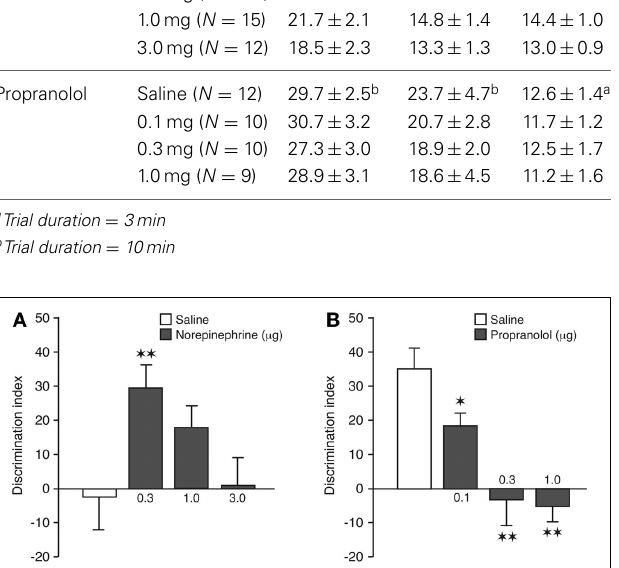
FIGURE 3 | Noradrenergic activation of the BLA modulates consolidation of object-in-context recognition memory. (A) Enhancing effects of post-training intra-BLA infusions of norepinephrine on 24-h object-in-context recognition memory. Saline-infused controls displayed no evidence of memory of 3min of training. The retention performance of the group given 0.3 μ g of norepinephrine was significantly better than that of the saline controls. Data are presented as discrimination index (mean ± s.e.m.; see main text). (B) Impairing effects of post-training intra-BLA infusions